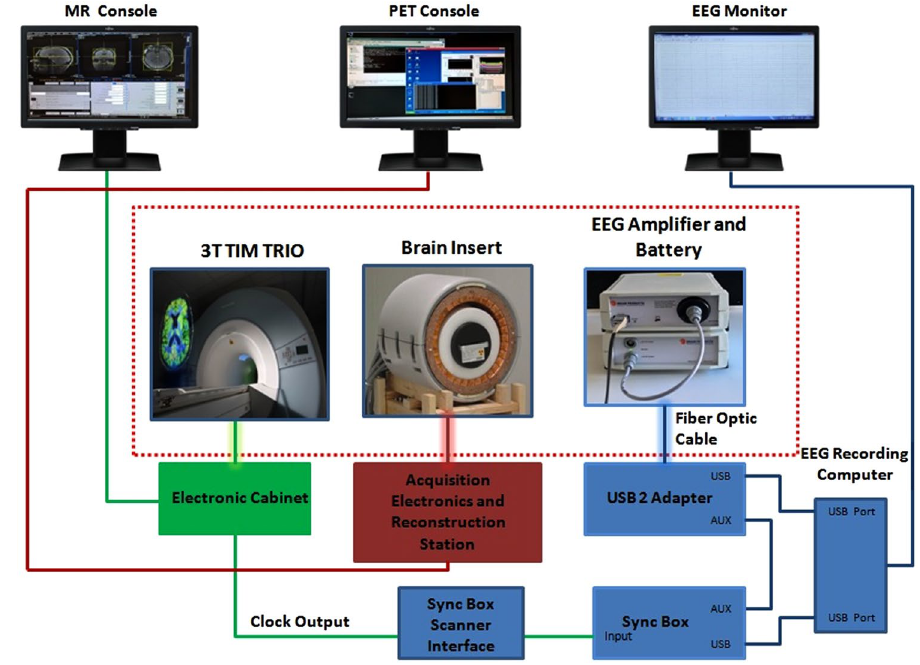
Figure 1. Trimodal set-up. The diagram displays the connections between the various components of the simultaneous MR-PET-EEG setup. The components inside the red dotted rectangular box are inside the RF- shielded MR